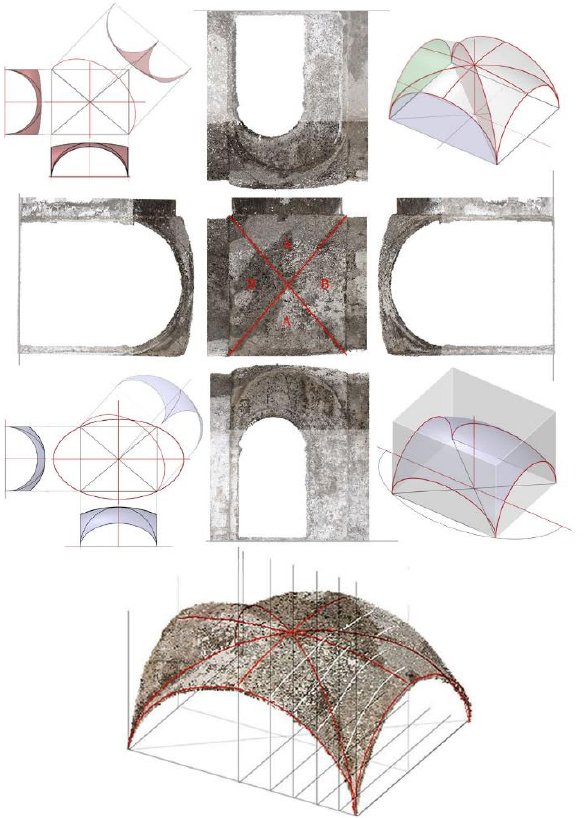
Figure 3. Point cloud segmentation: arches and surfaces hypothesis.